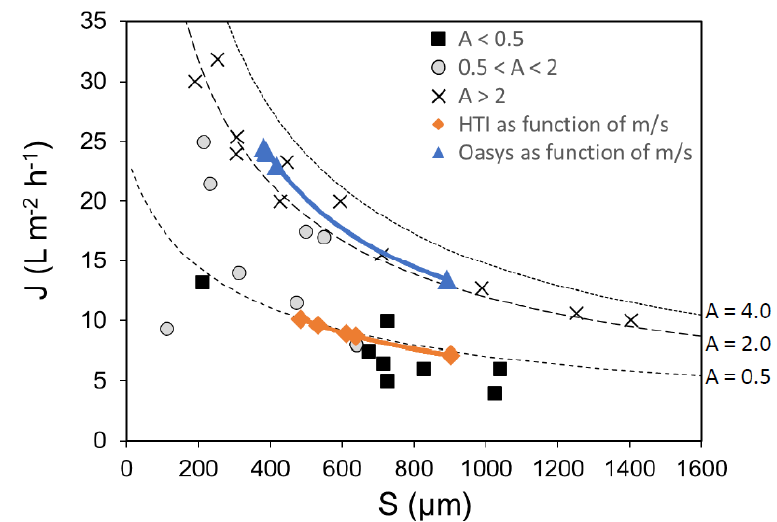
Figure 4. Correlation between determined the S parameter and forward osmosis flux for different A (L m −2 h −1 bar −1 ) values. The data from hollow fiber membranes gathered from literature ([114–130]) for FO mode with 1 M NaCl as a draw solution. Data from the HTI and Oasys membranes for 1 M NaCl at different crossflow velocities (extracted from [113]). The dotted lines represent the theoretically expected fluxes for membrane permeances of 4.0, 2.0, and 0.5 (L m −2 h −1 bar −1 ) respectively based on their S parameter.